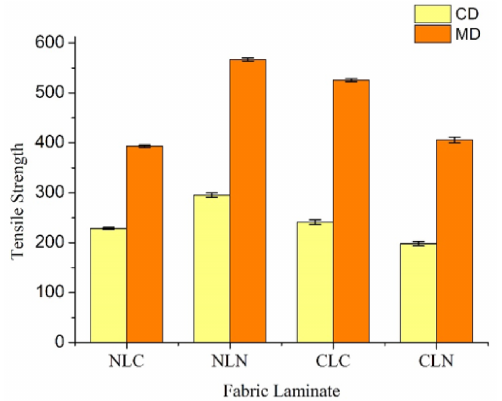
Figure 3. Tensile strengths of the NLC, NLN, CLC, and CLN composites. Table 1. Tensile strengths of sandwich-structured